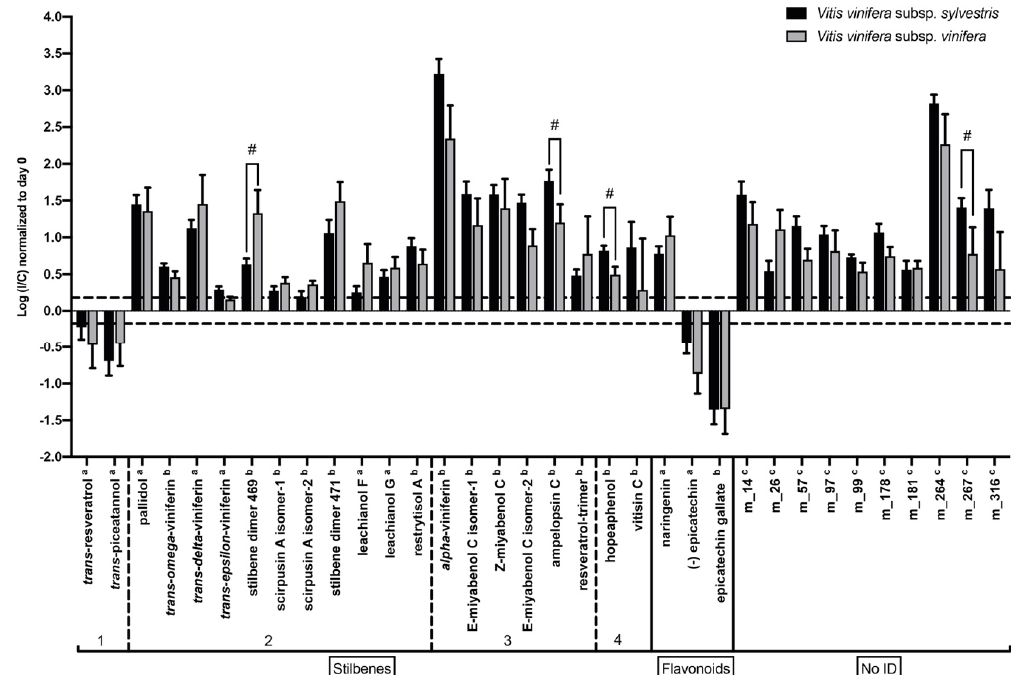
Figure 6. Changes in specialized metabolite contents at seven DPI. Contents are expressed as the log of the ratio between content (normalized to T0) in inoculated sample (I) and content in mock-inoculated control sample (C). Metabolite contents are represented in black for V. v. subsp . sylvestris and in gray for V. v. subsp . vinifera . # represents a (I/C) statistically significantly different for V. v. subsp . sylvestris and V. v. subsp . vinifera ( p < 0.05). a indicates confirmed metabolites by standard, b indicates putative metabolites identified by MS/MS, and c indicates non-characterized metabolites. Error bars represent standard error of the mean. For stilbenes, 1-2-3 and 4 indicates monomeric, dimeric, trimeric and tetrameric forms, respectively.